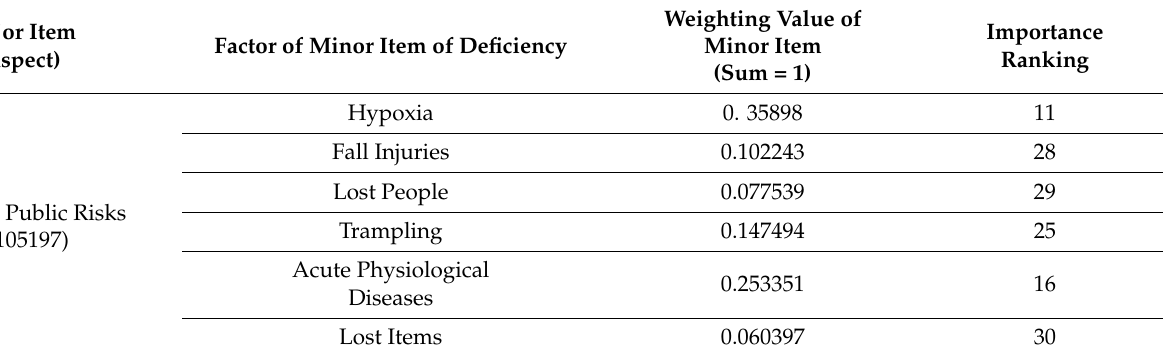
Table 6. Weighting values for potential public